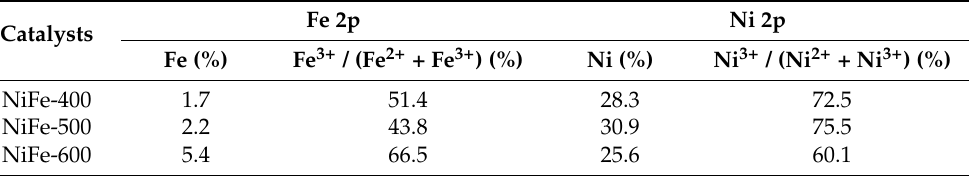
Figure 6. The ideal model of catalysts with MO x (M = Ni or Fe) or multiple phases (MO x and a NiFe 2 O 4 spinel).